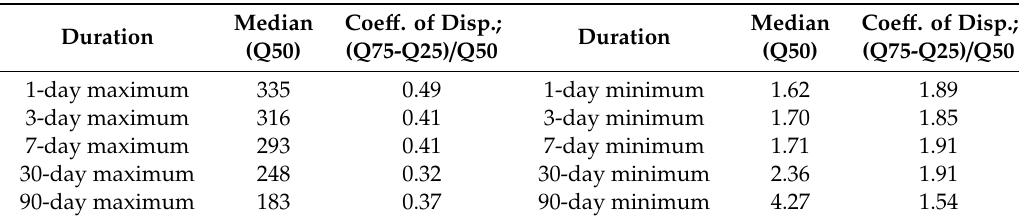
Table 2. Minimum and Maximum Flow (m 3 s − 1 ) of Di ff erent Duration in Gumara River at the ‘outlet’. These are the common variables in the Ecological Limits of Hydrologic Alteration (ELOHA) analysis. Table 3. Mean decadal (a) low- and (b) high-flows (m 3 s − 1 ) and decadal percentage changes of Gumara River at the ‘outlet’. The mean decadal low flow showed a decreasing trend since 1973–1980 and